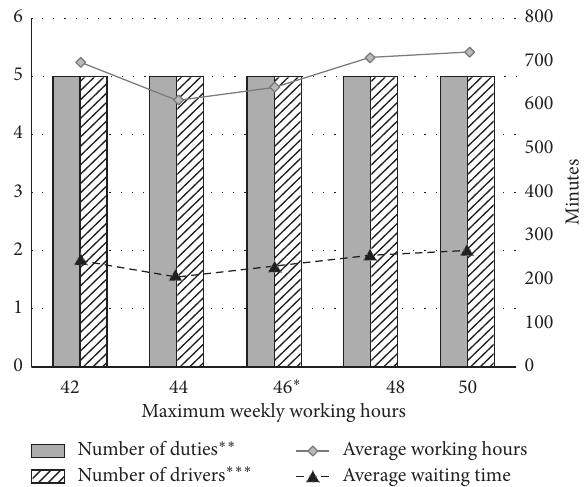
Figure 11: Sensitivity analysis of the maximum weekly working hours. Note . ∗ Current value and comparison basis. ∗∗ The number of duties required to cover the timetable. ∗∗∗ The number of drivers required for the